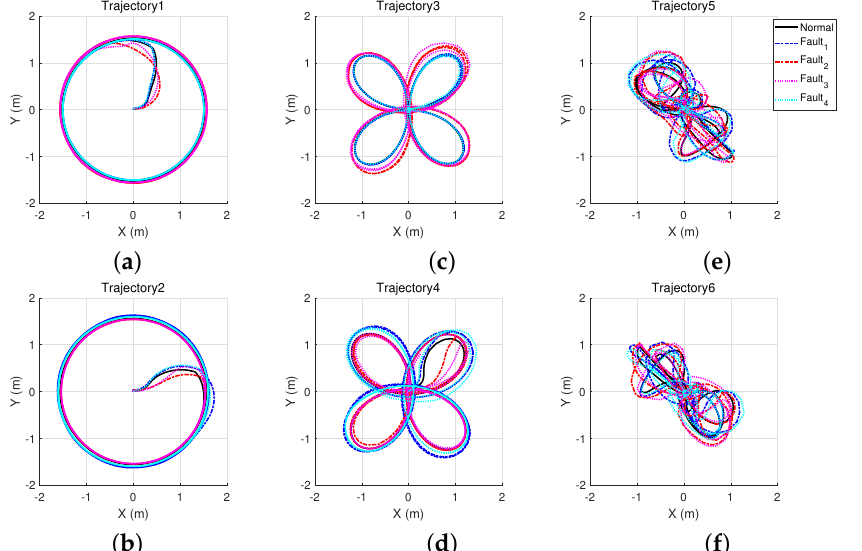
Figure 8. Experiment data without disturbance. Normal is no fault condition, Fault 1 is the first actuator fault, Fault 2 is the second actuator fault, Fault 3 is the third actuator fault, and Fault 4 is the fourth actuator fault. ( a ) Circular (CCW). ( b ) Circular (CW). ( c ) Clover (CCW). ( d ) Clover (CW). ( e ) Modified Clover (CCW). ( f ) Modified Clover (CW).